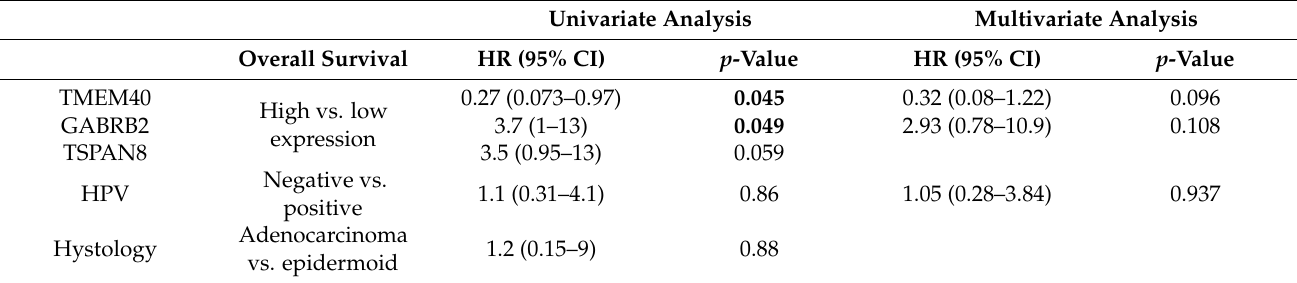
Figure 5. Kaplan-Meier OS analysis of Mexican-Mestizo patients. ( A ) Differences in the OS of patients with high and low expression of GABRB2. ( B ) Differences in the OS of patients according to TSPAN8 expression. ( C ) Differences in the OS of patients according to TMEM40 expression. Blue lines represent patients with low gene expression, and red lines represent patients with high gene expression. Table 4. Univariate and multivariate cox regressions in the Mexican-Mestizo CC